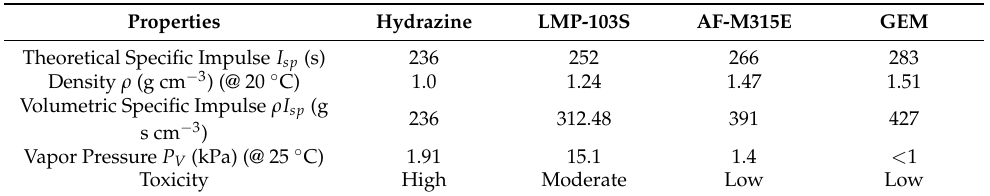
Table 4. Performance and physical properties of Green Electric Monopropellant (GEM) compared to state-of-the-art Green Monopropellants (@ 2.0 MPa chamber pressure, 50:1 expansion ratio, and vacuum conditions) [46].